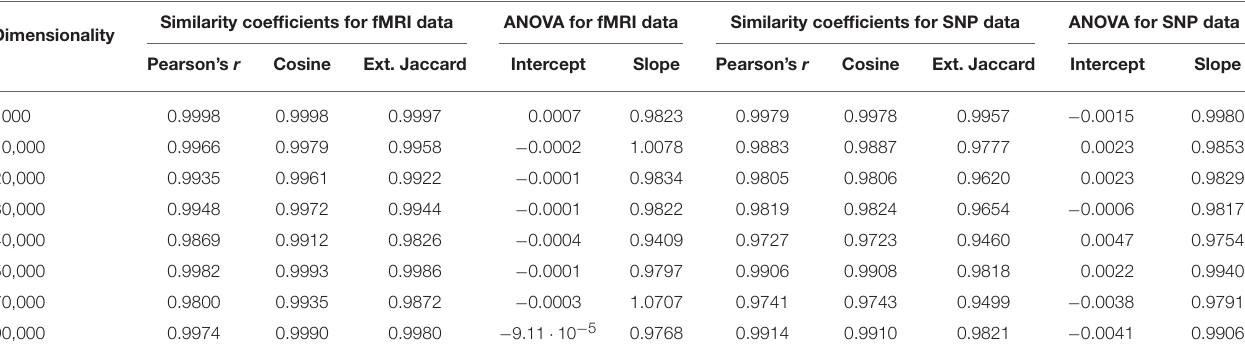
We evaluated the performance of PLSC-RP by comparing its weight profiles to the weight profiles of PLSC. We applied three similarity measures, Pearson correlation, the cosine measure and the extended Jaccard similarity. In addition, we used ANOVA for comparison. The ANOVA model represents a perfect linear relationship between the weights of PLSC and PLSC-RP, in case the intercept equals 0 and the slope equals